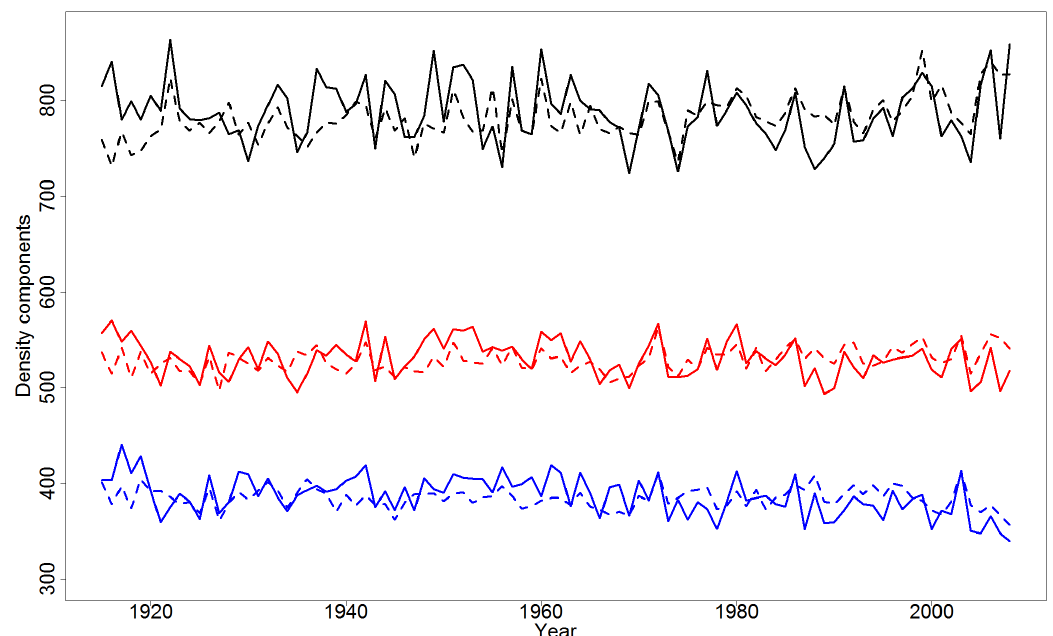
Figure 3. Ring density components (mean observed and predicted values) against calendar year for co-dominant trees from 1915 to 2008. Observations were displayed by solid lines and predictions were depicted by dashed lines. Different density components are represented by the different colors, minimum ring density (blue lines); maximum ring density (black lines) and average ring density (red lines).